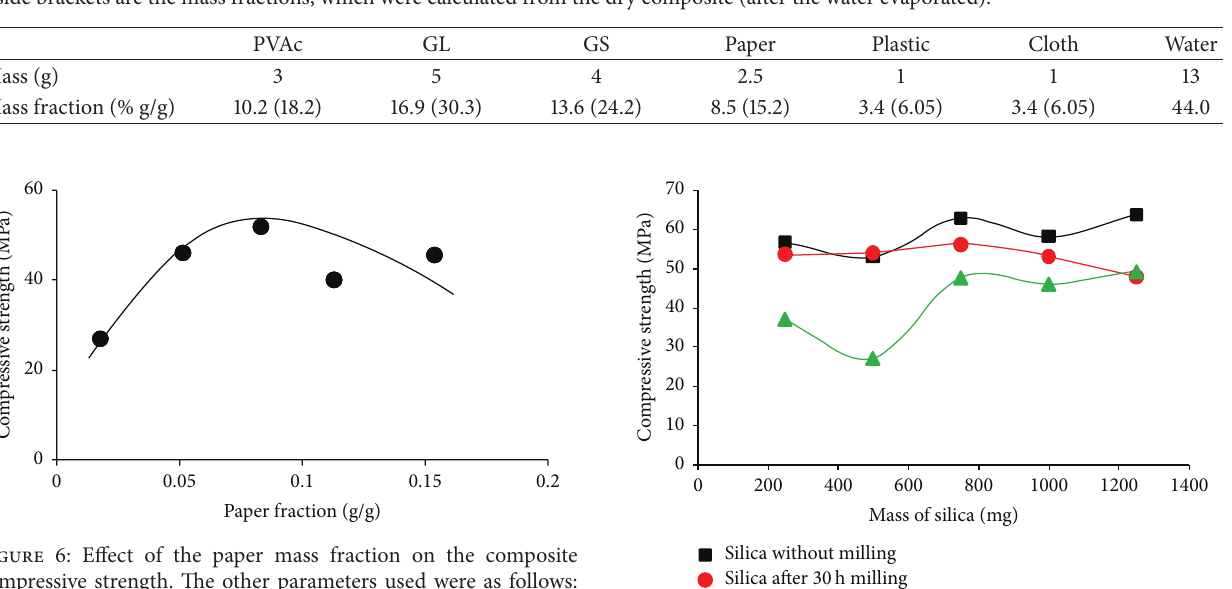
Table 2: The optimum parameters that produce the highest compressive strength. The hot-press temperature used was 250 ∘ C. The figures inside brackets are the mass fractions, which were calculated from the dry composite (after the water evaporated).